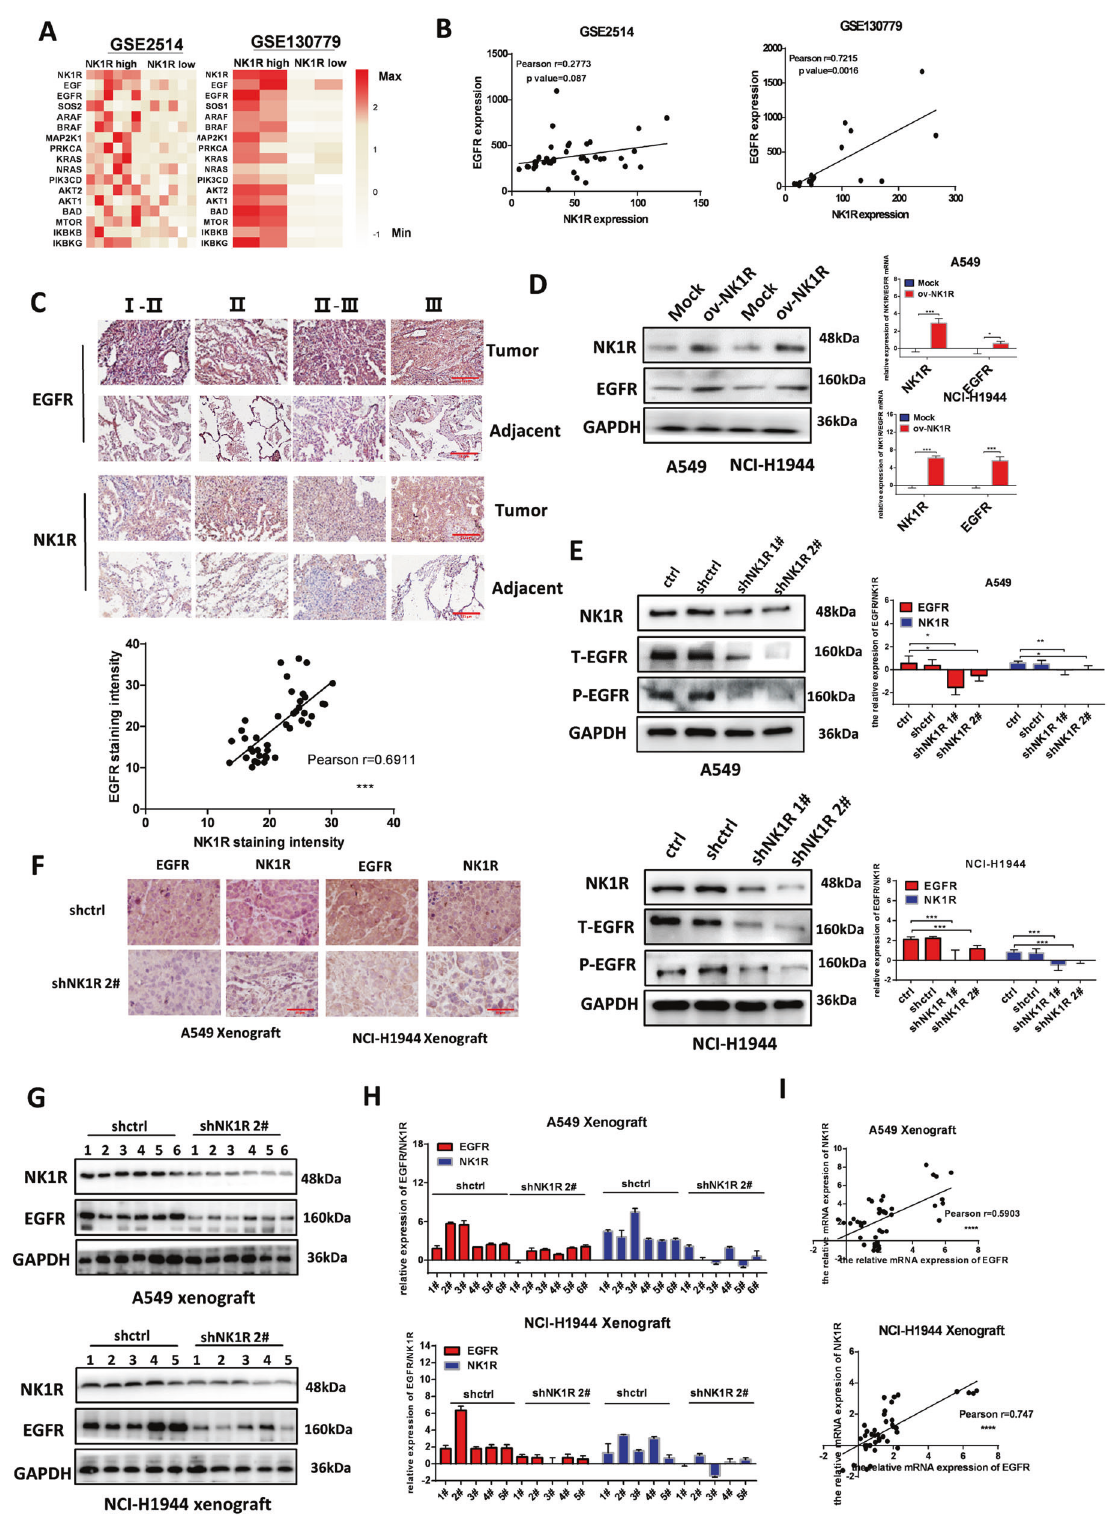
MMP2 and − 14, showing the reduced ability of tumor cell metastasis (Fig. 3D, E). In addition, shNK1R-transfected A549 and NCI-H1944 cells showed no response to hHK-1 treatment. Aprepitant reduced cell proliferation and blocked hHK-1-induced cell colony formation (Fig. 3F). Flow cytometry of PI/Annexin V